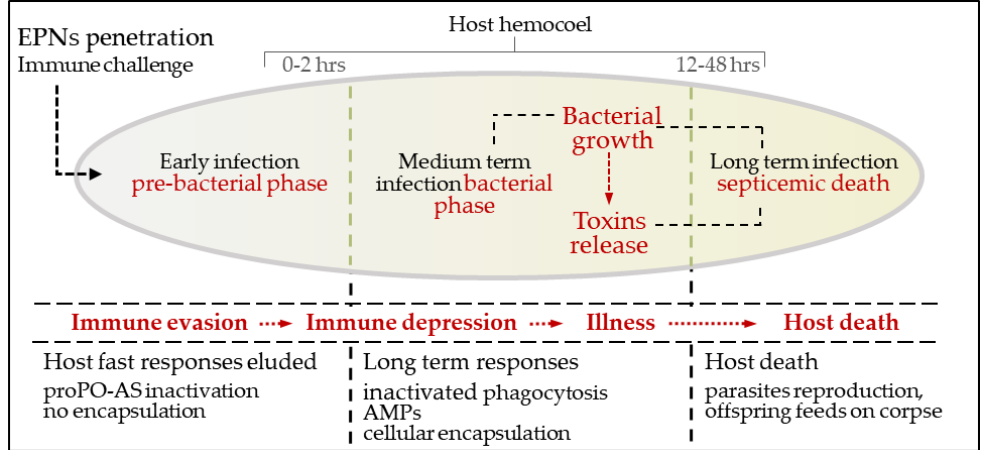
Figure 12. EPNs: time course of EPNs infection, modulation of immune response and host death.